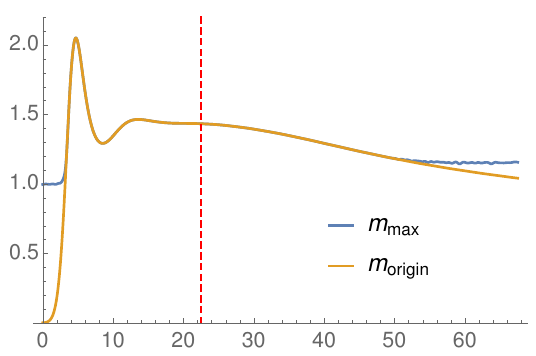
Figure 7 . Time evolution of the maximum of the energy density m max and its value at the origin m . After a short period, these two values become equal, signaling rigid rotation. At late times, (0 ; 0) their values begin to di(cid:11)er, as a consequence of the break up of the bar. We extract the pro(cid:12)les at a time t (cid:25) 22, shown in red, and plot them in (cid:12)gure 8 below.